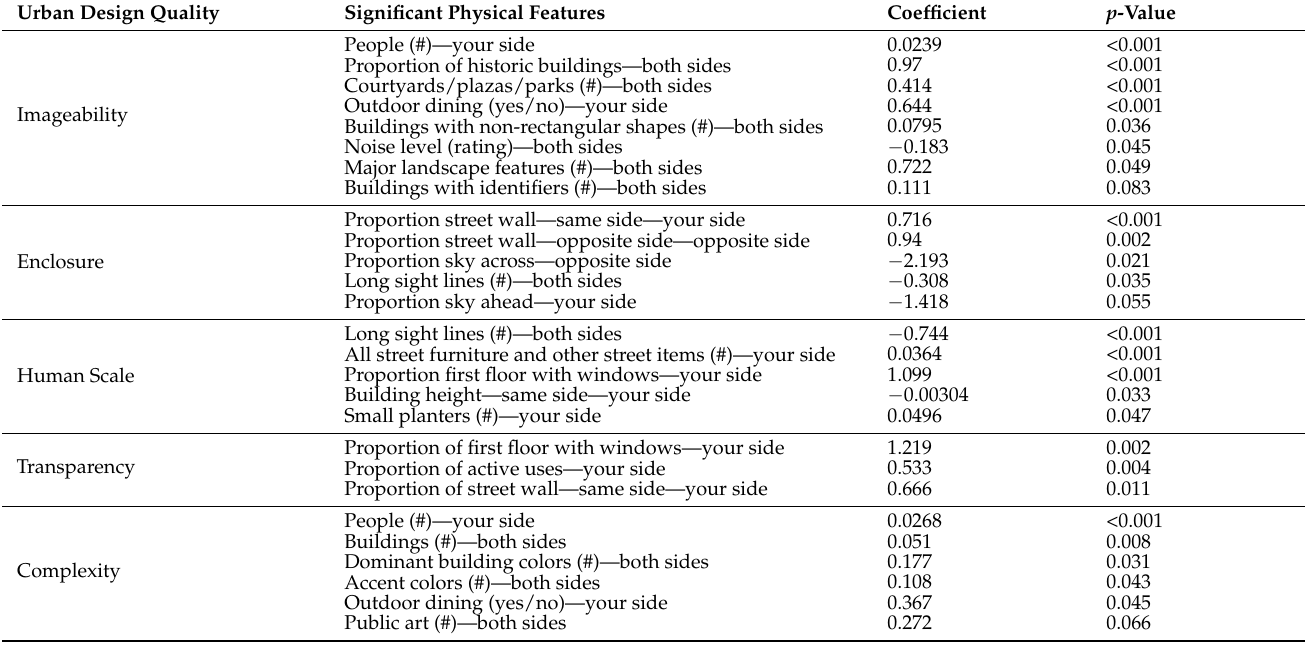
Table 3. Urban Design Qualities, Their Physical Features, Coefficients and p -Values (Adapted from source